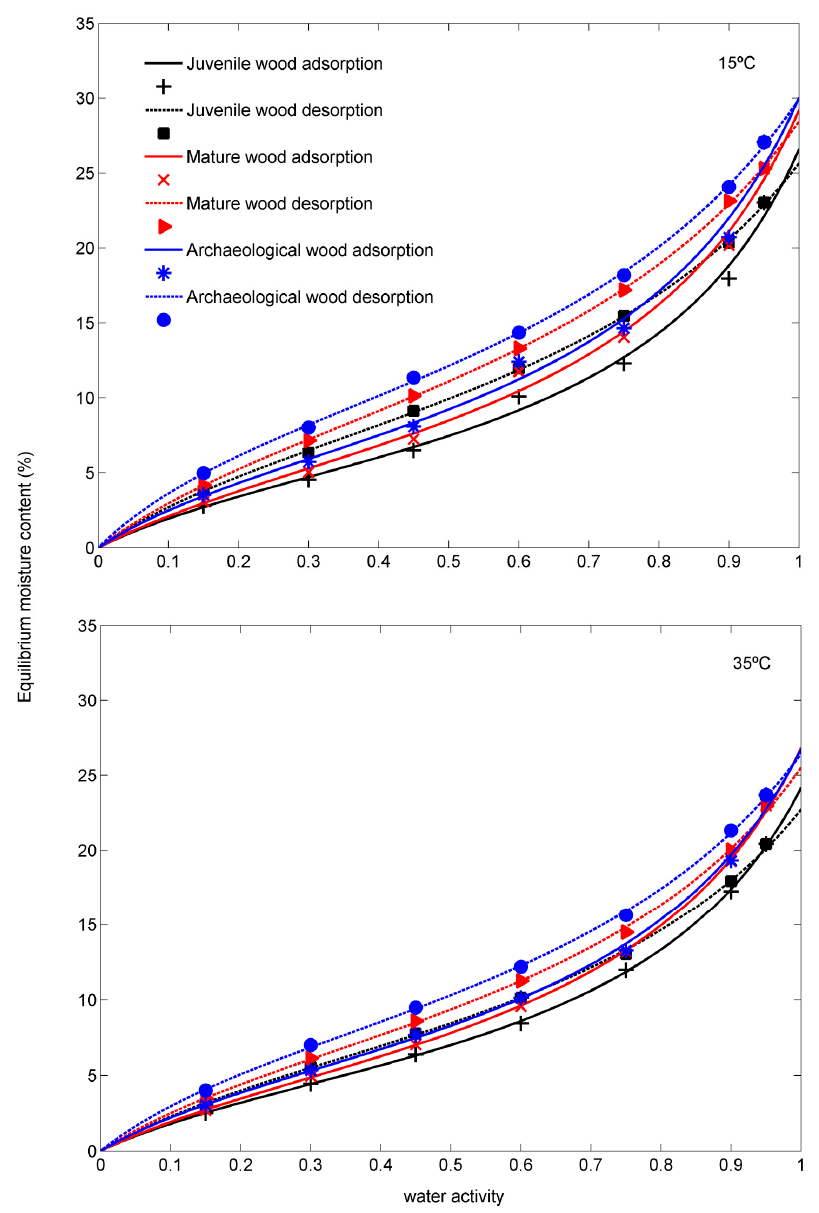
Figure 3. The 15 °C and 35 °C adsorption-desorption isotherms of juvenile, mature, and archaeological